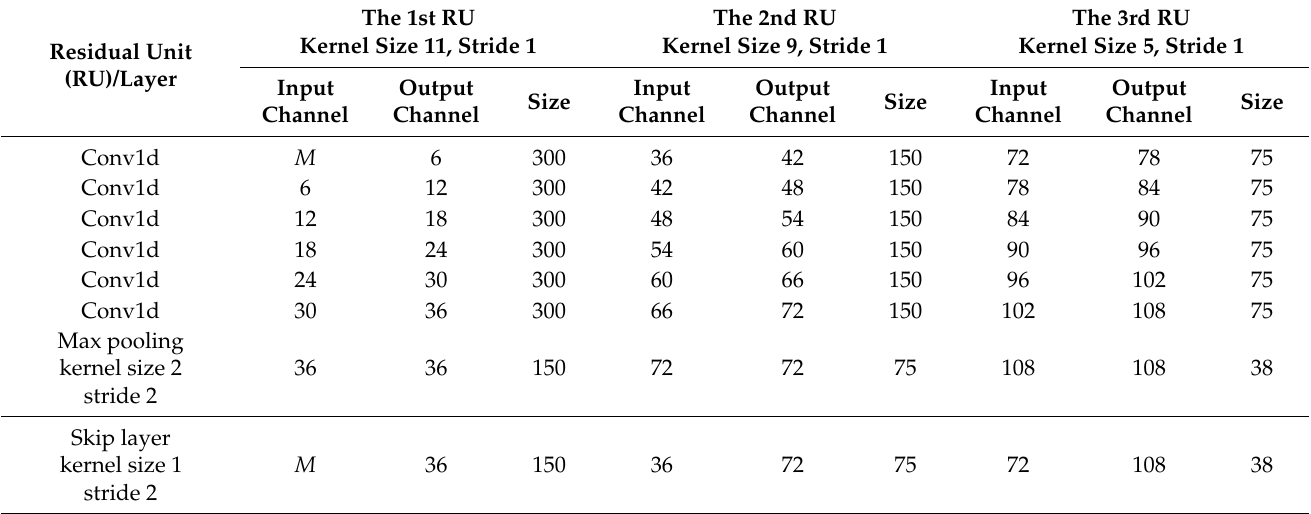
Table 3. Deep residual network architecture.